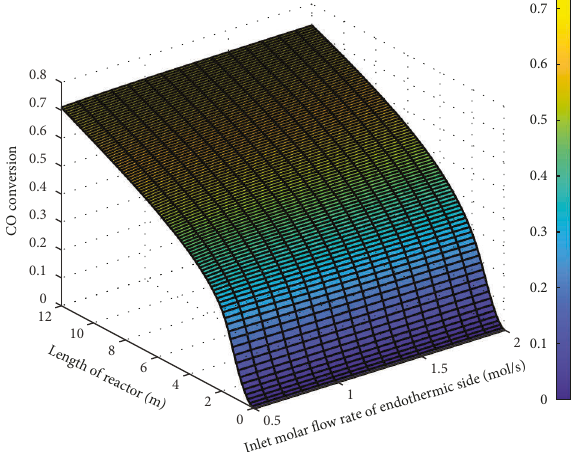
Figure 9: Effect of input molar flow rate at the endothermic part on conversion percentage of CO and MEK yield.